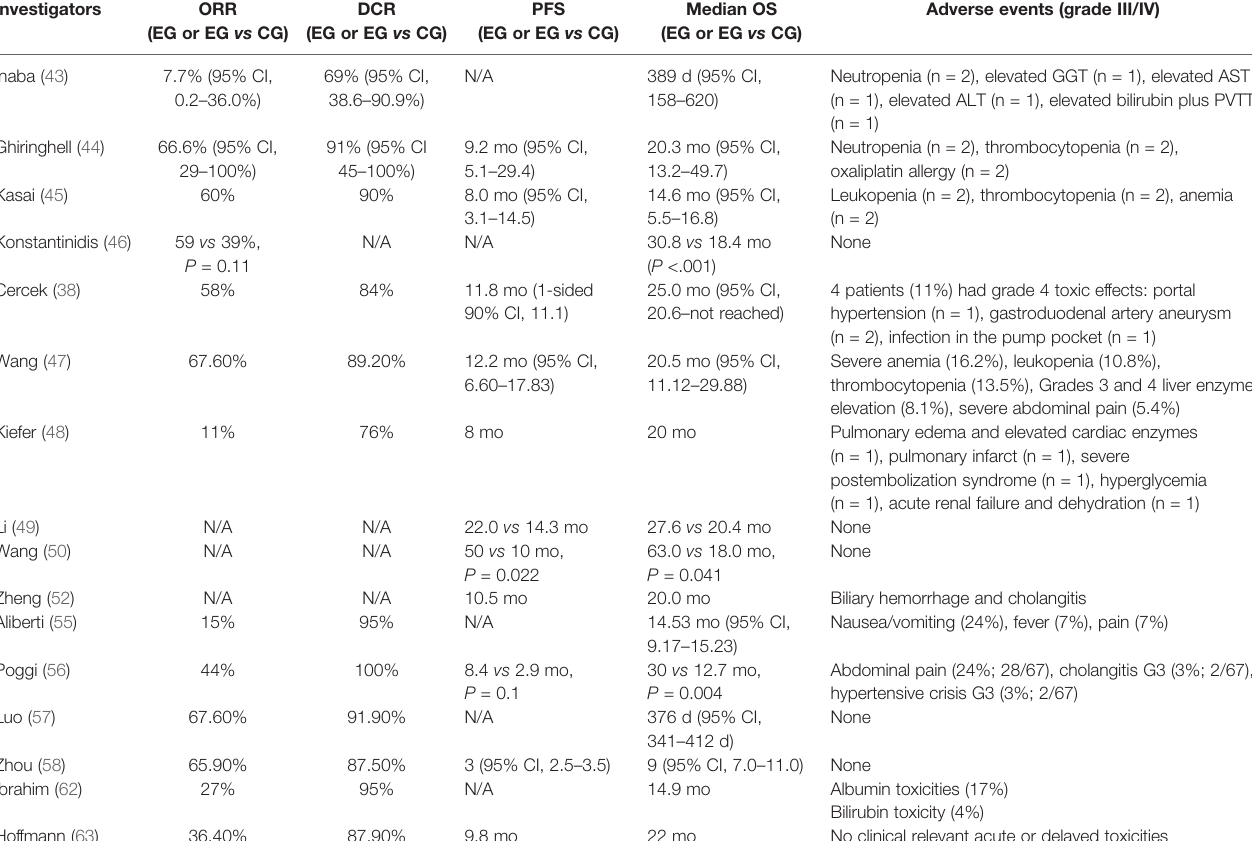
TABLE 2 | Results and adverse events within included studies for IAS.